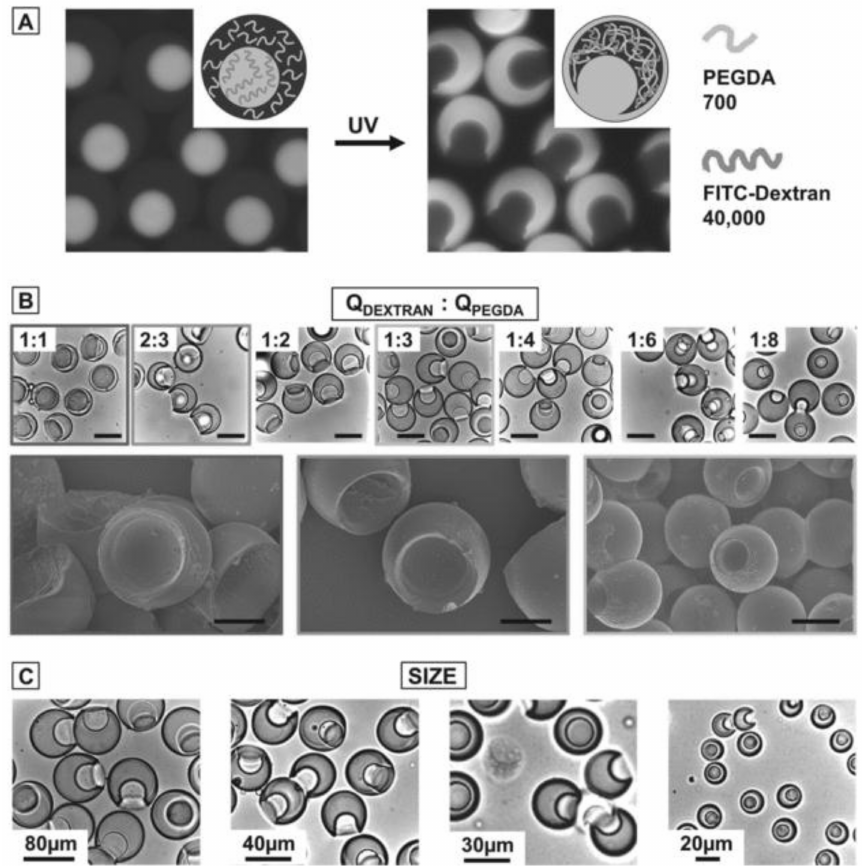
Figure 3. Selective polymerization of dextran/ poly-(ethylene glycol) diacrylate (PEGDA) core–shell droplets. ( A ) Fluorescence images of phase-separated aqueous two-phase system (ATPS) droplets consisting of a fluorescently labeled dextran core and a non-labeled PEGDA shell. During polymerization, dextran migrates into the PEGDA shell. As the core is depleted of dextran, the resulting microgel particle contains a socket. ( B ) Bright-field microscopy images of gel microparticles with a socket. The socket size is determined by the flow rate ratio of dextran and PEGDA (upper row). Scanning electron micrographs of selected samples (lower row). The scale bars denote 80 µ m in the upper row and 30 µ m in the lower row. ( C ) Bright-field microscopy images of particles with different sizes. While the overall flow rate of the ATPS mixture and the fluorinated oil is kept constant, the total particle size is determined by the flow rate ratio of the ATPS mixture and the fluorinated oil phase as well as the height of the second microfluidic nozzle, which is either 75 or 20 µ m. (S. Ma et al., Copyright 2012 WILEY-VCH Verlag GmbH & Co. KGaA,